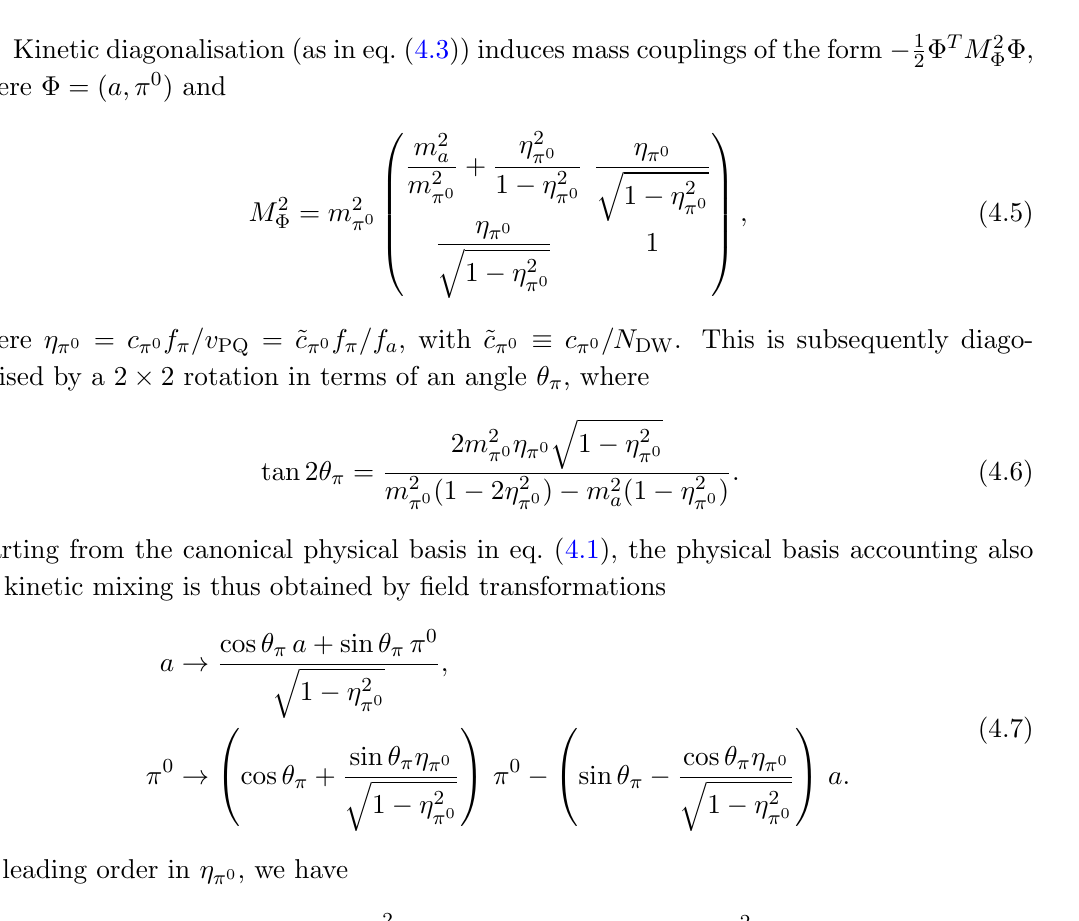
Table 3 . Limits on v PQ from contributions to neutral meson mass di(cid:11)erences. Measured values of (cid:1) m P are given in the PDG [78]. Meson decay constants f given in